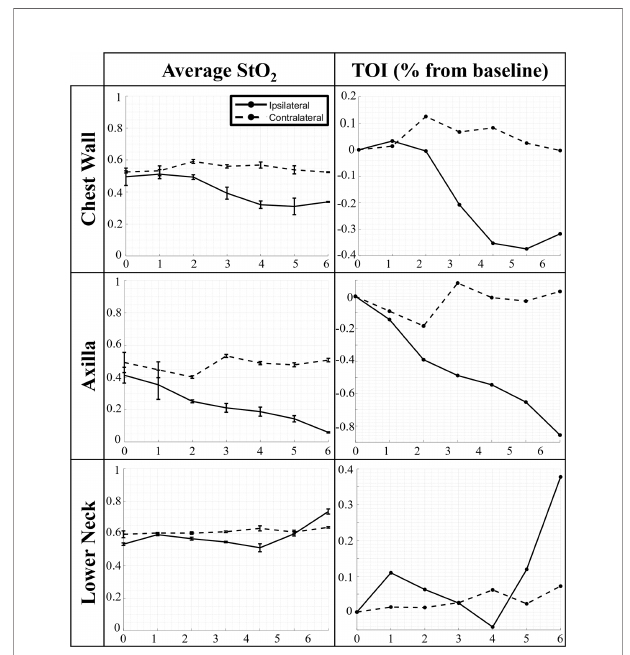
FIGURE 3 | Changes in average oxygen saturation (StO 2 ) and tissue oxygenation index (TOI) across weeks of RT for every imaged region (chest wall, axilla, and lower